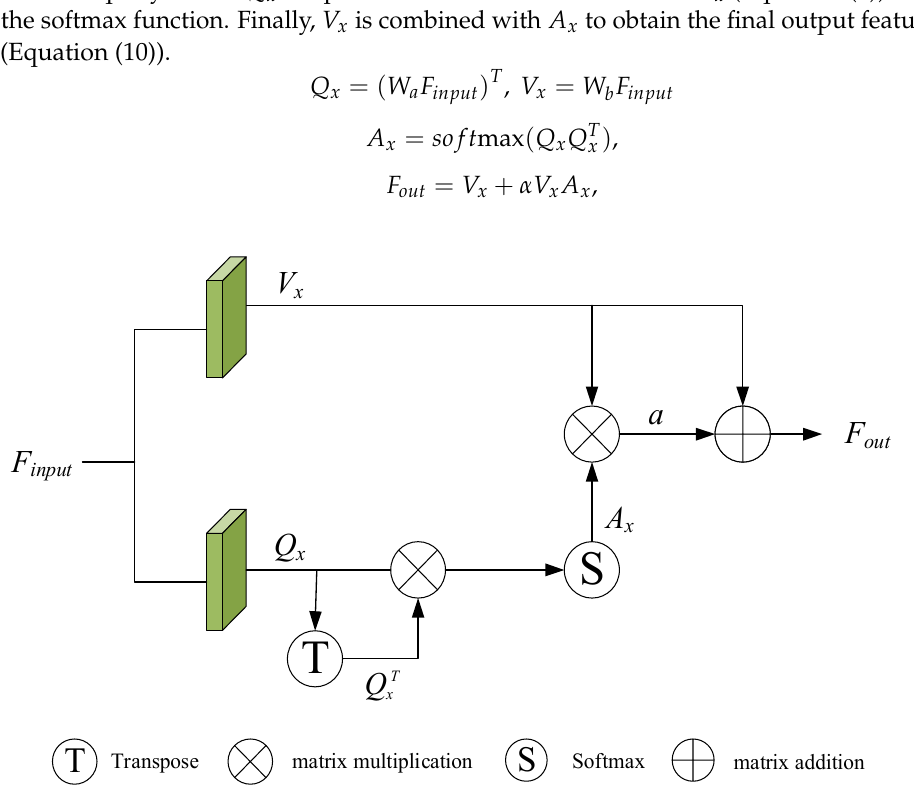
Figure 3. The details of self-attention block structure.